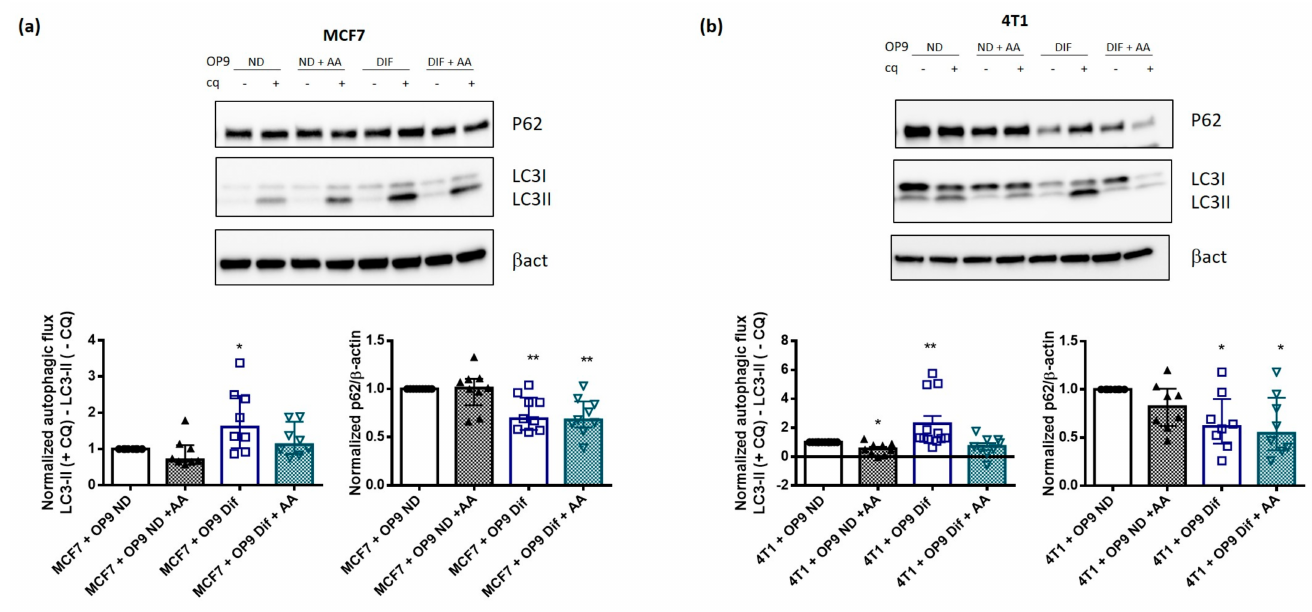
Figure 4. Arachidonic acid supplementation prevents the activation of autophagy by adipocytes in breast cancer cells. ( a , b ) Representative western blots and quantification of normalised autophagic flux and p62 protein expression in MCF7 ( a ) and 4T1 ( b ) cells in co-culture with OP9 ND and OP9 Dif, with and without arachidonic acid (AA, 20 µ M) for 48 h. To calculate the autophagic flux, 20 µ M chloroquine (CQ) was used for 18 h (Median ± interquartile range, Wilcoxon Signed Rank Test * p < 0.05 and ** p < 0.01, n =